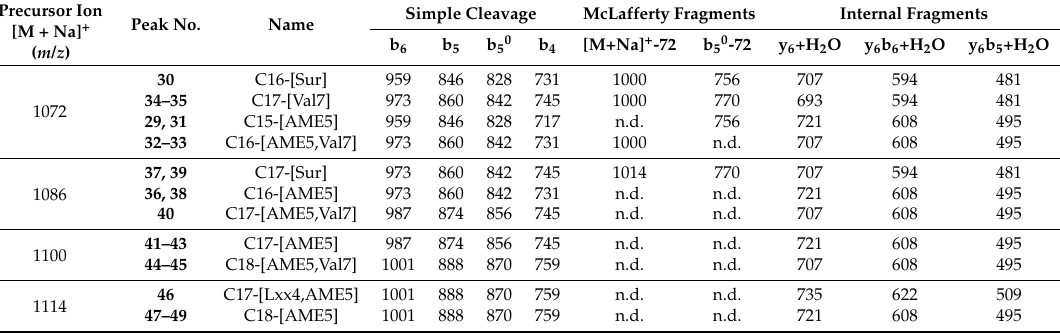
Table 2. Characteristic ions of the different surfactin isoforms found in the sample from the fragmentation of m / z 1072, 1086, 1100, and